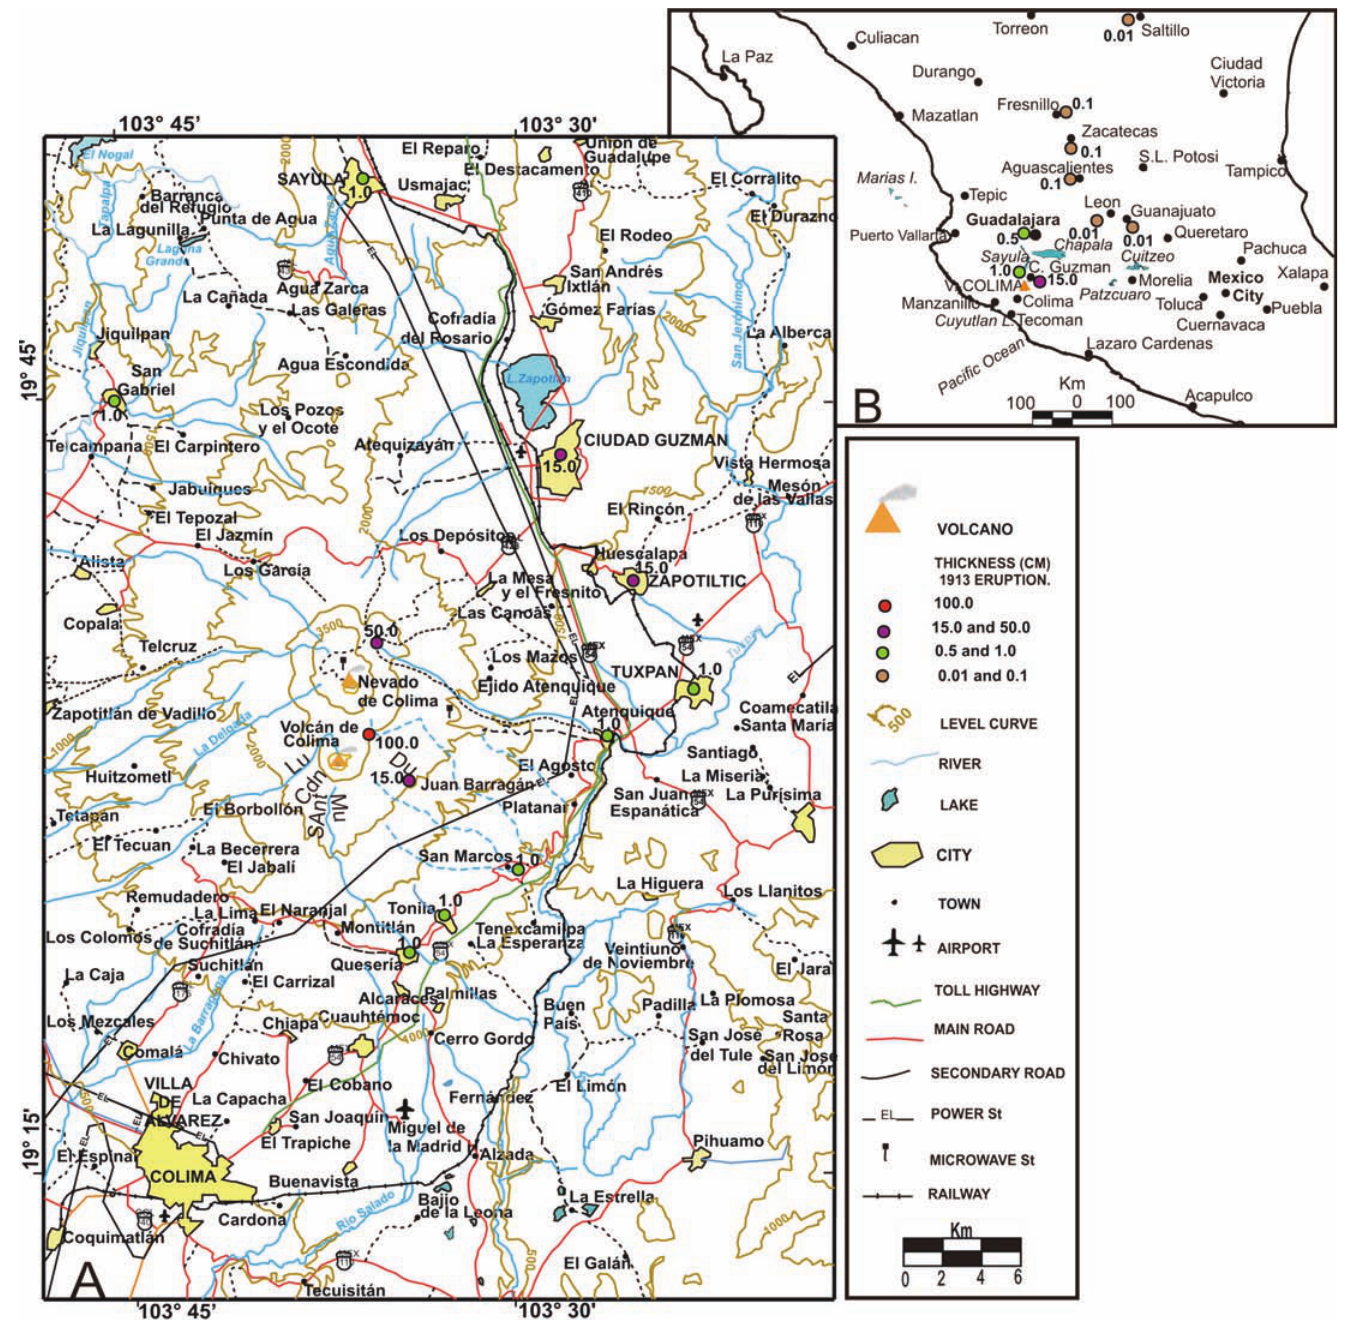
Figure 1. A: Map of the Colima Volcano and cities affected in 1913 by ash fall. Lu: La Lumbre; SAnt: San Antonio; Mu: El Muerto; Du: Durazno; Cdn: Cordoban. B: Localitation of Volcano in